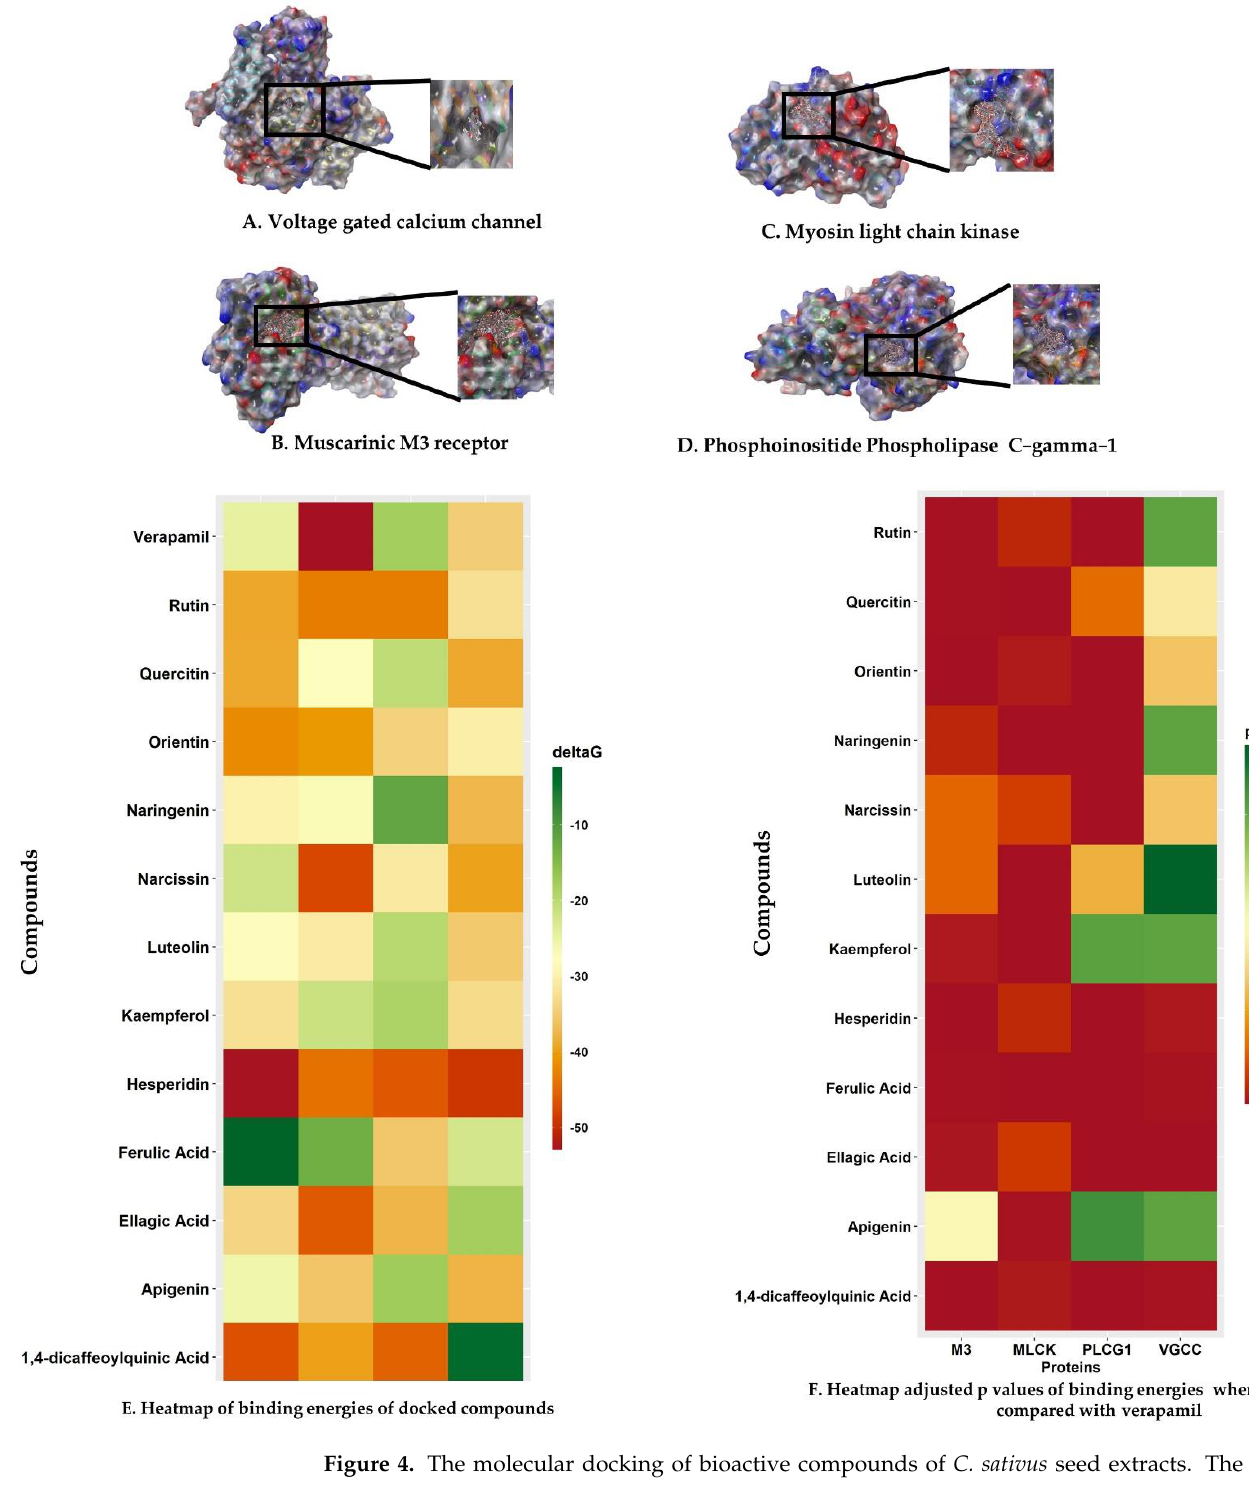
Figure 4. The molecular docking of bioactive compounds of C. sativus seed extracts. The three-dimensional protein – ligand interaction of bioactive compounds with ( A ) voltage-gated calcium channel; ( B ) muscarinic M3 receptor; ( C ) myosin light chain kinase; ( D ) phosphoinositide phospholipase C – Gamma – 1; ( E ) Heatmap of bioactive chemical and protein binding energies (kcal/mol); ( F ) Heatmap of p -adjusted binding energy values in comparison to verapamil.